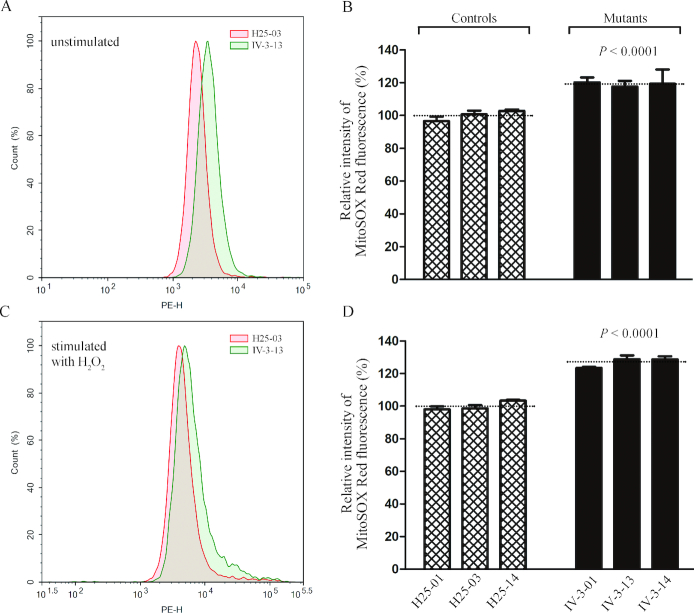
Measurement of mitochondrial ROS. Ratio of geometric mean intensity between levels of the ROS generation in the vital cells with or without H2O2 stimulation. The rates of mitochondrial ROS production in three mutant cybrid cell lines, three control cell lines and HUVECs, were analyzed by BD-LSR II flow cytometer system using MitoSOX Red Mitochondrial Superoxide Indicator. Flow cytometry histogram showing MitoSOX-Red fluorescence of H25-03 (red) and IV-3-13 (green) without (A) or with (C) H2O2 stimulation. The relative ratios of fluorescence intensity (stimulated versus unstimulated with H2O2) was calculated: (B) and (D). Graph details and symbols are explained in the legend to Figure 3.